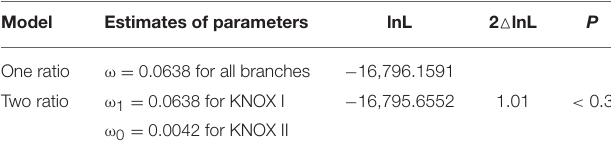
TABLE 1 | Summary statistics for detection of selection using branch models of